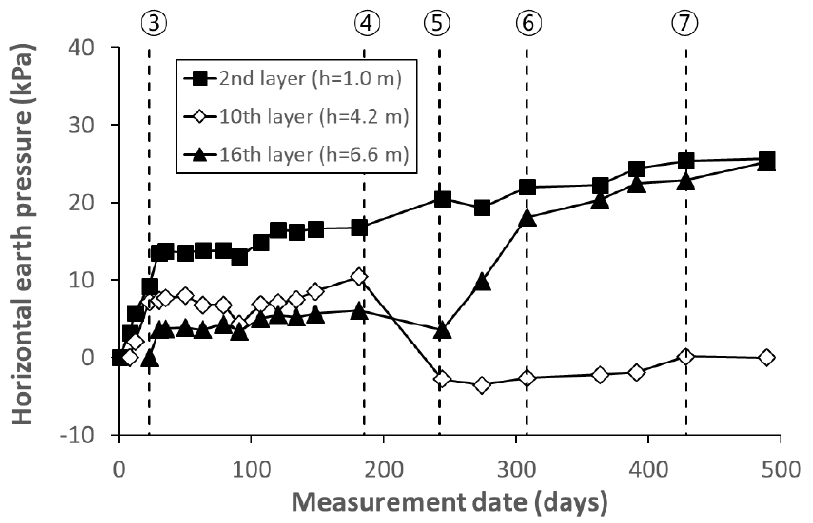
Figure 8. Net settlement of reinforced backfill and rainfall over time.